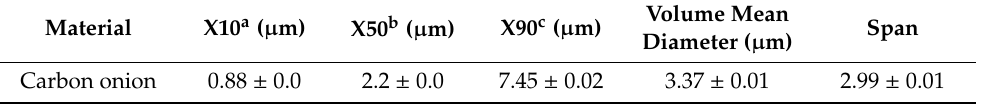
Table 1. Particle size characteristics of carbon onions obtained from laser di ff raction analysis. Material X10 a ( µ m)